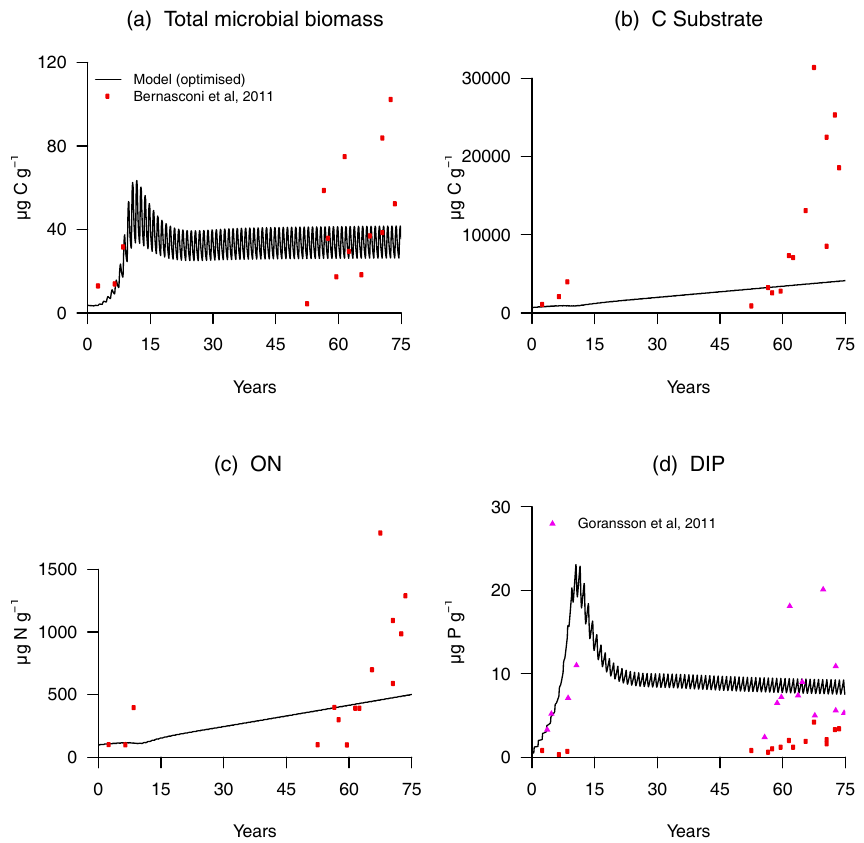
Figure 11. Model output optimised to observational data from the Damma Glacier, Switzerland.